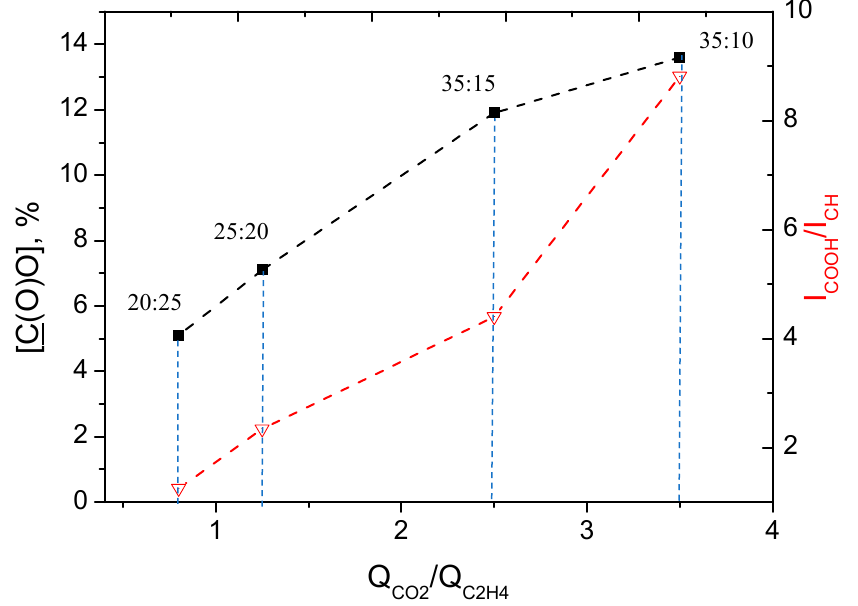
Figure 6. Dependence of C=O/CH peak intensity ratio (I C=O /I CH ) and C(O)O concentration on Q CO2 /Q C2H4 .